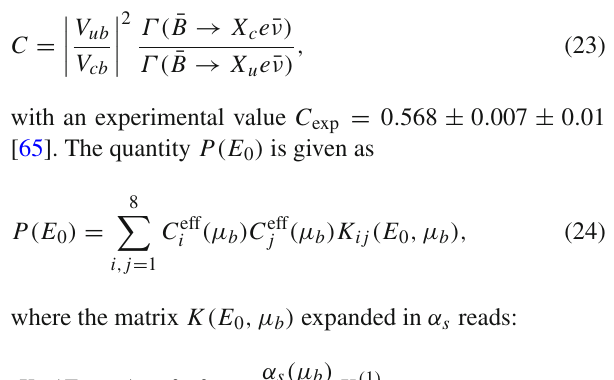
Fig. 7 Dependence of BR( ¯ B → X s γ ) on the SMEFT coefficients ˜ C (μ = m ) . Only one coefficient is varied at a time while the other i t two are set to zero. The grey band denotes the experimental